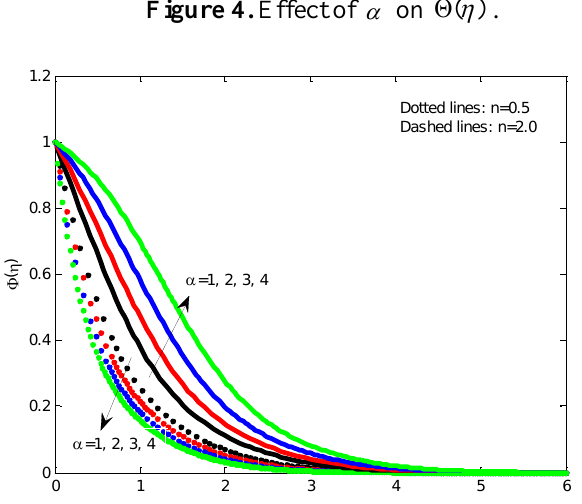
Figure 5. Effect of  on ( ) 